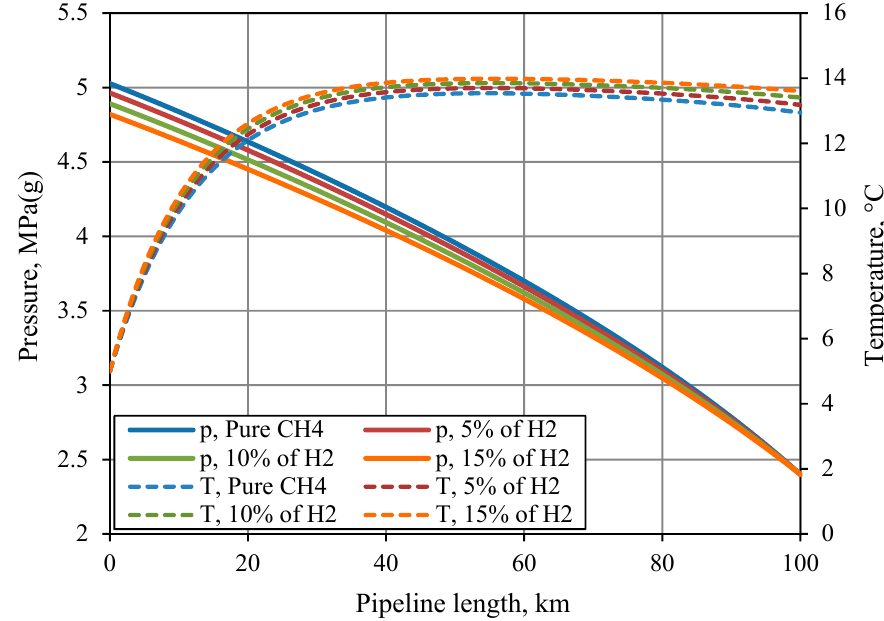
Figure 15. Pressure ( p ) (continuous line) and temperature ( T ) (dashed line) changes as a function of hydrogen content in mixture with methane and pipeline length.